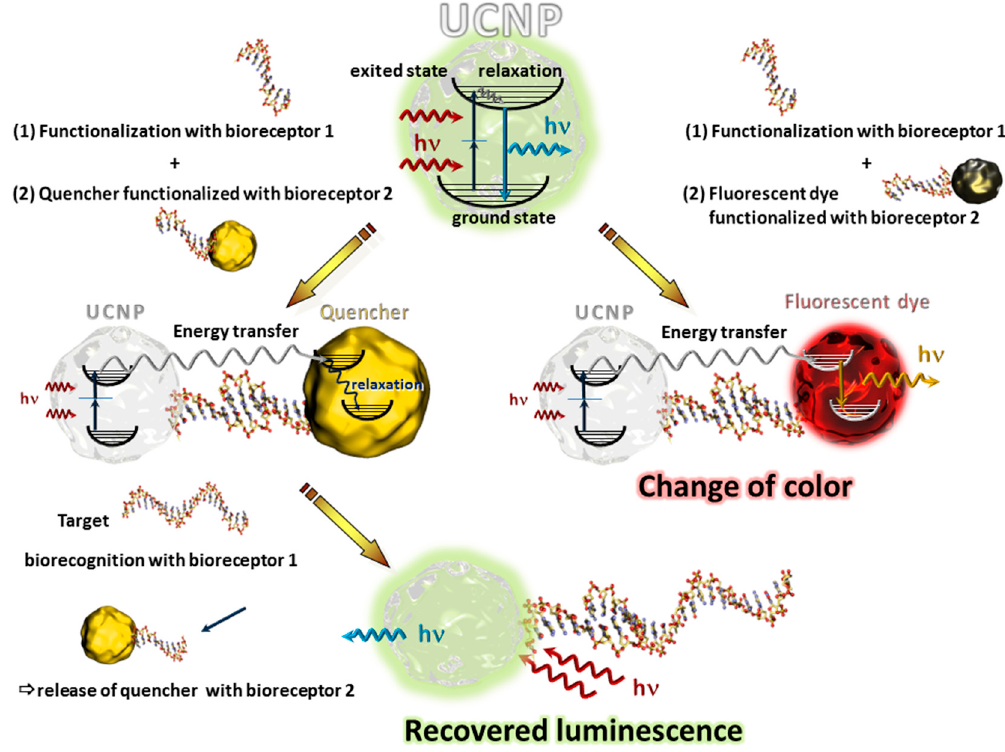
Figure 1. Schematic presentation of an UCNP and its anti-stokes type emission (top) and their functioning as bioanalytical transducer using a nanosized quencher (left) or a fluorescent dye (right).